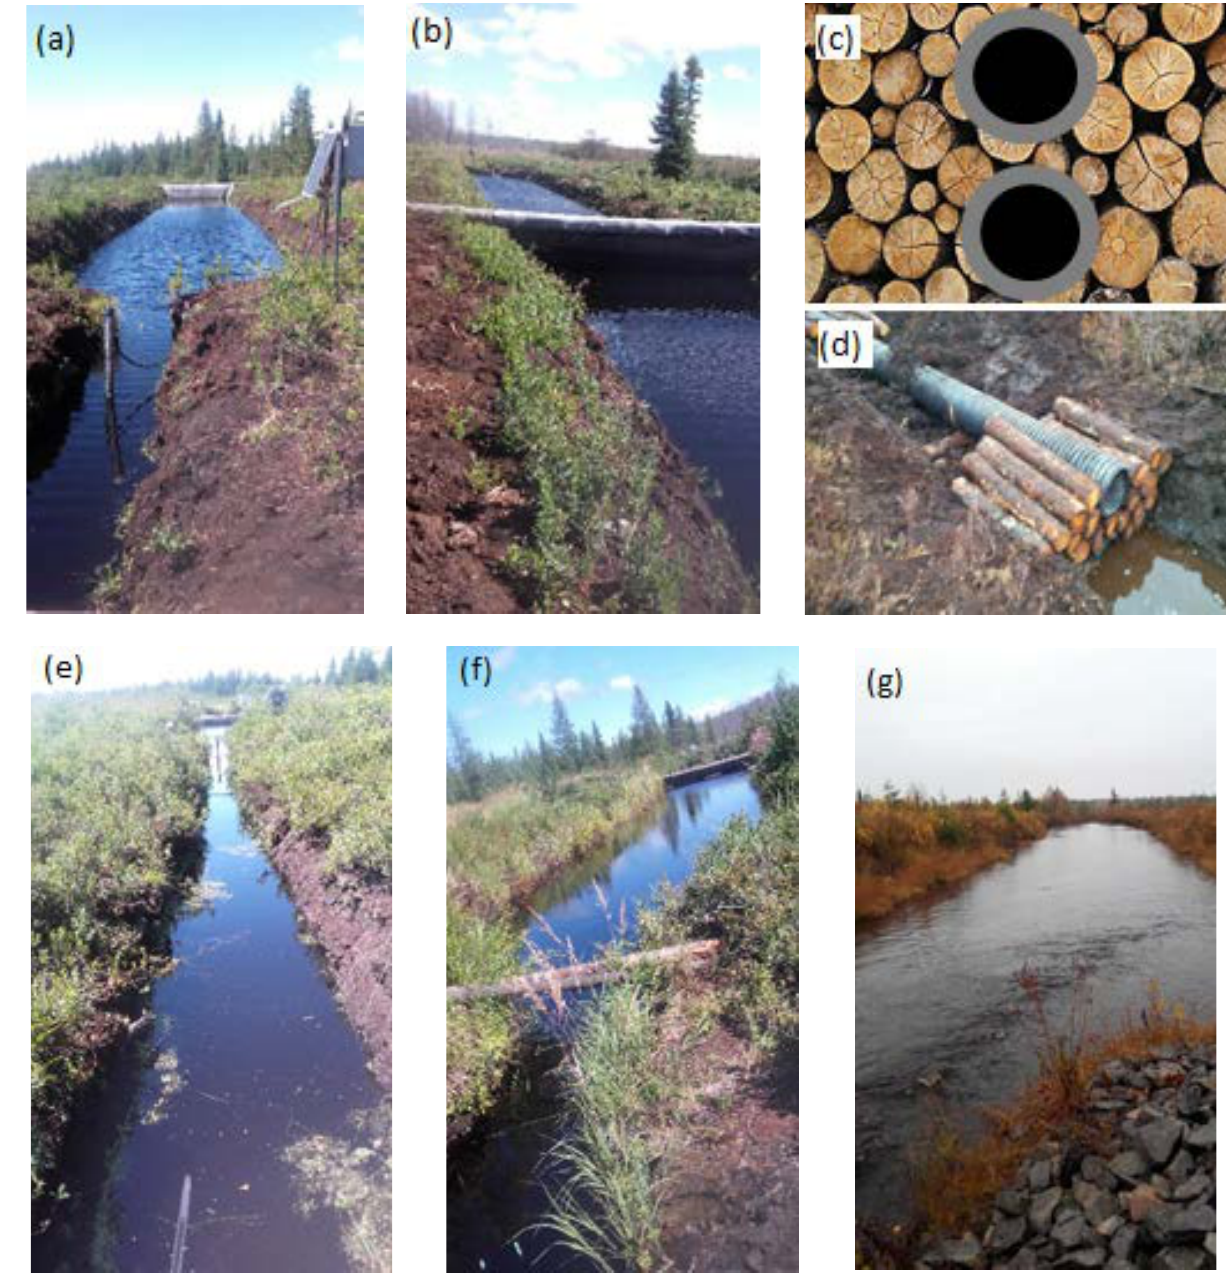
Figure 2. (a) Inflow channel and Basin B1; (b) geotextile in Basin B1; (c) (d) double pipe culvert; (e) channel connecting Basin B1 and Basin B2; (f) Basin B2 with the geotextile in the middle and the output canal; (g) Basin